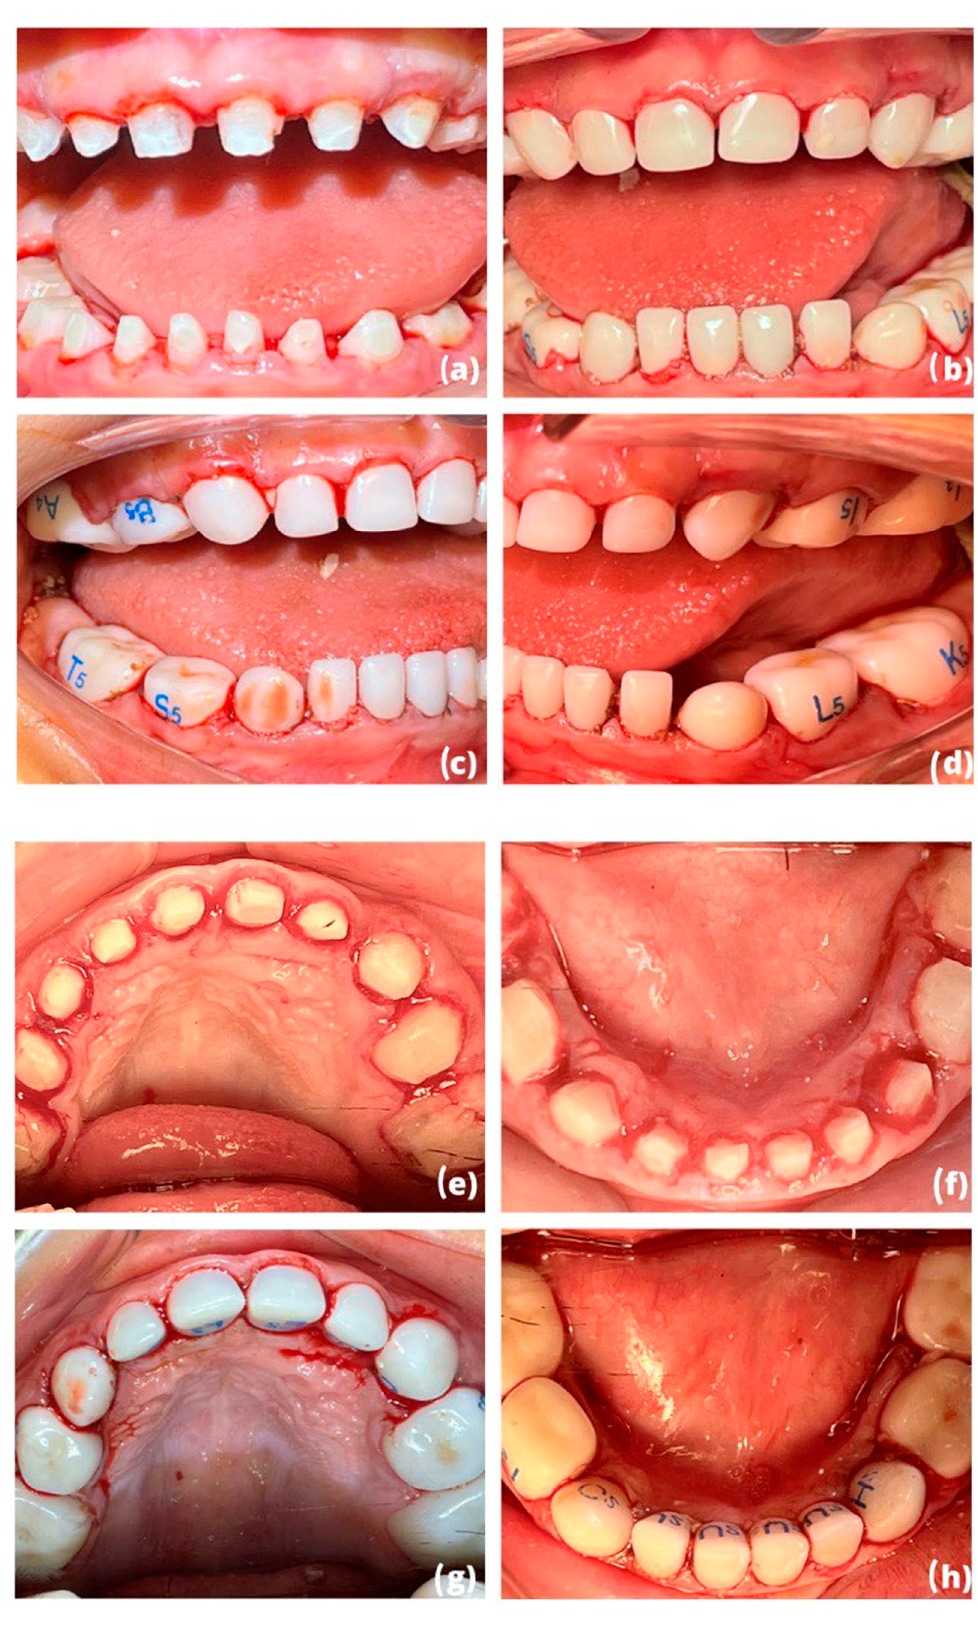
Figure 3. ( a – h ): ( a , e , f ) Intraoperative situation after performing pulpotomy and polishing of our preparations (clinical view); final situation after cementation of preformed pediatric zirconia crowns ( b – d , g , h ).